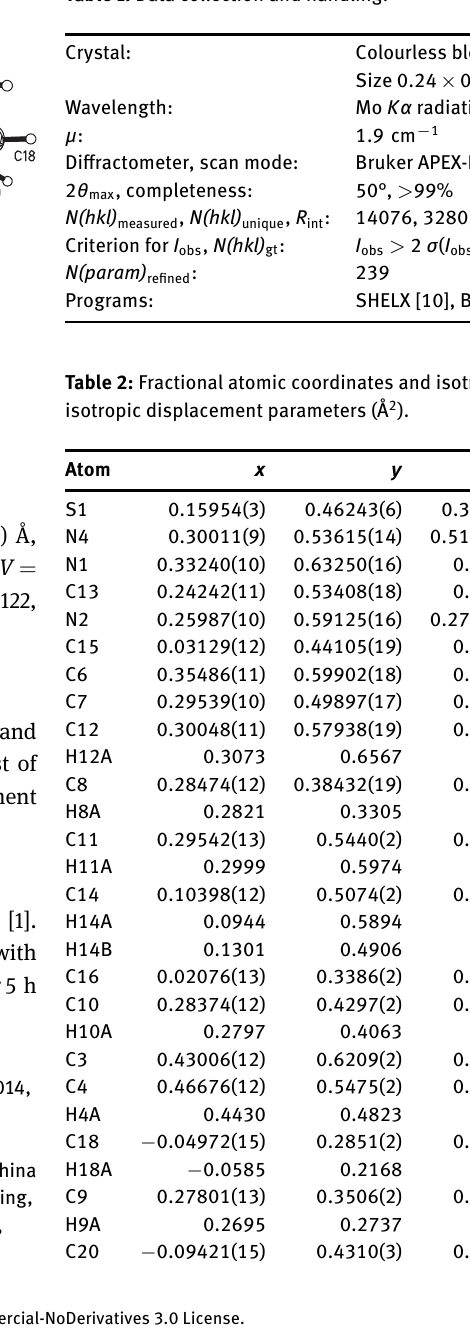
Table 1: Data collection and handling.